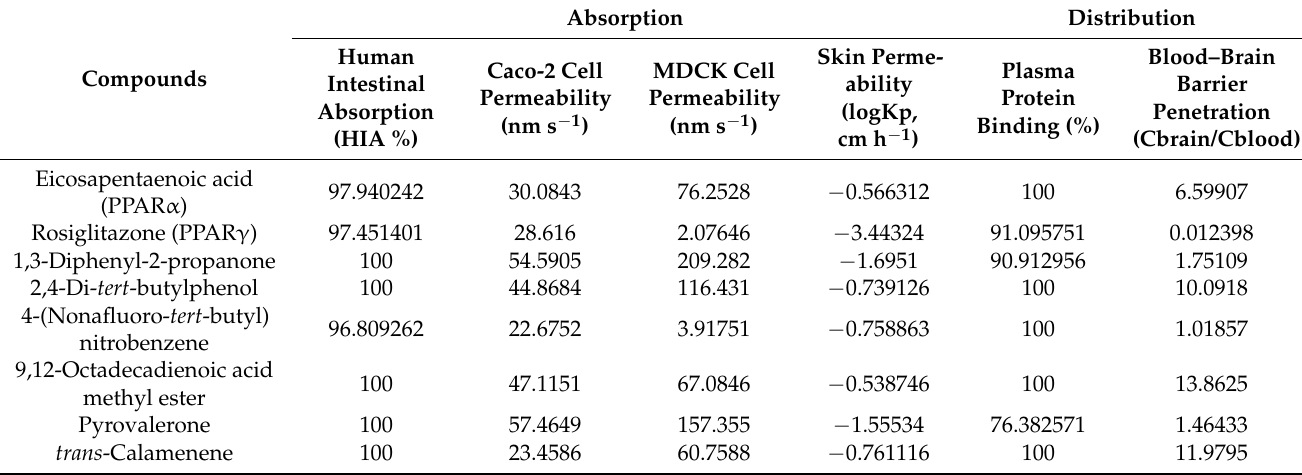
Table 10. In silico ADME profiling of CGJ, a volatile compound acquired from the PreADMET server.